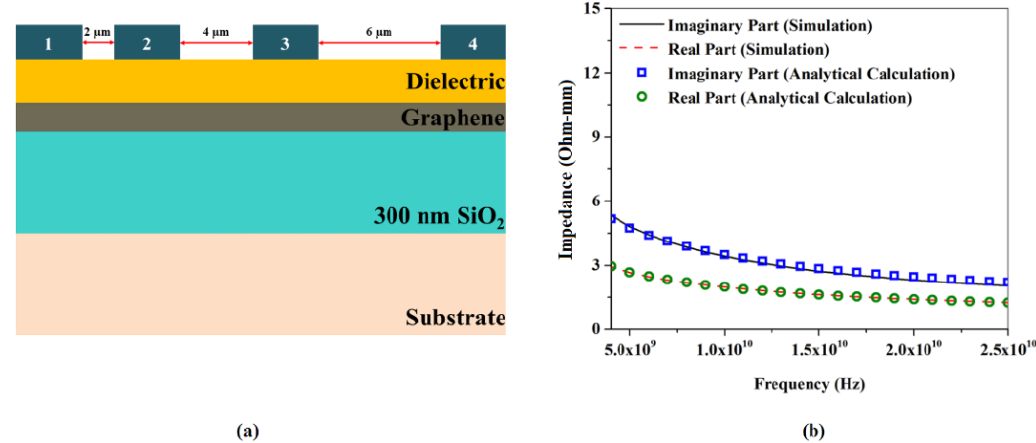
Figure 8. ( a ) Schematic of RF TLM structure on graphene; ( b ) the real and imaginary part of C3 impedance estimated from both simulation and analytical calculations, plotted with respect to frequency.